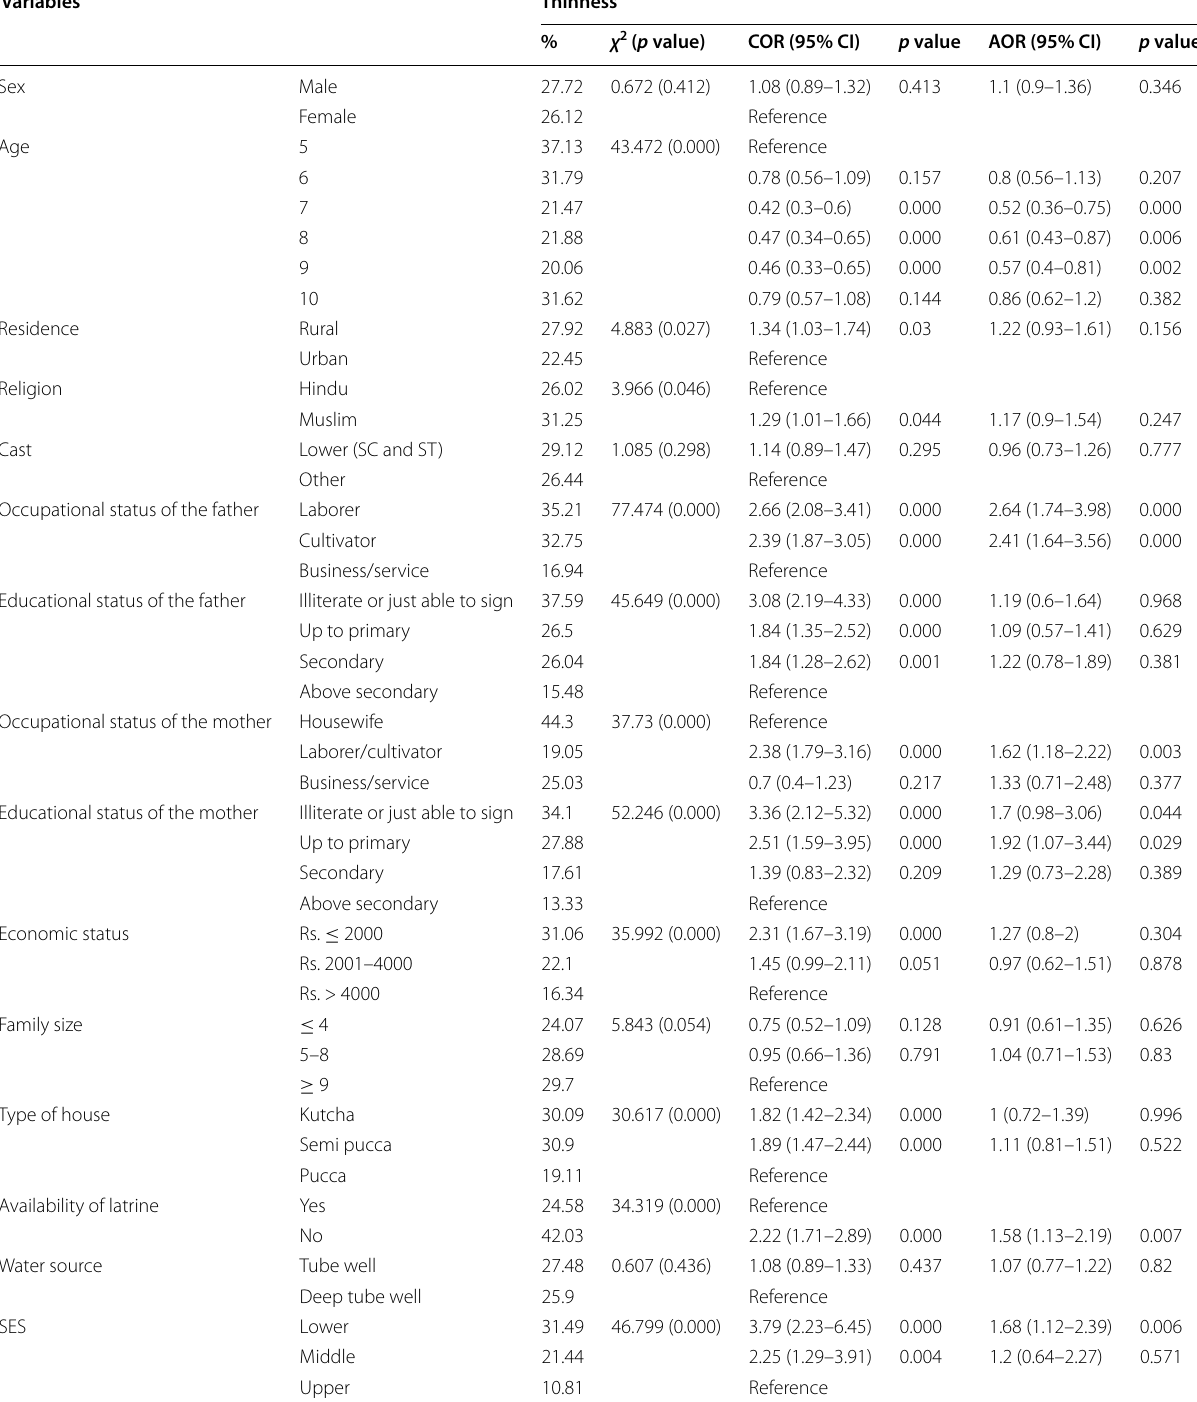
Table 5 Factors associated with thinness among children aged 5–10 years